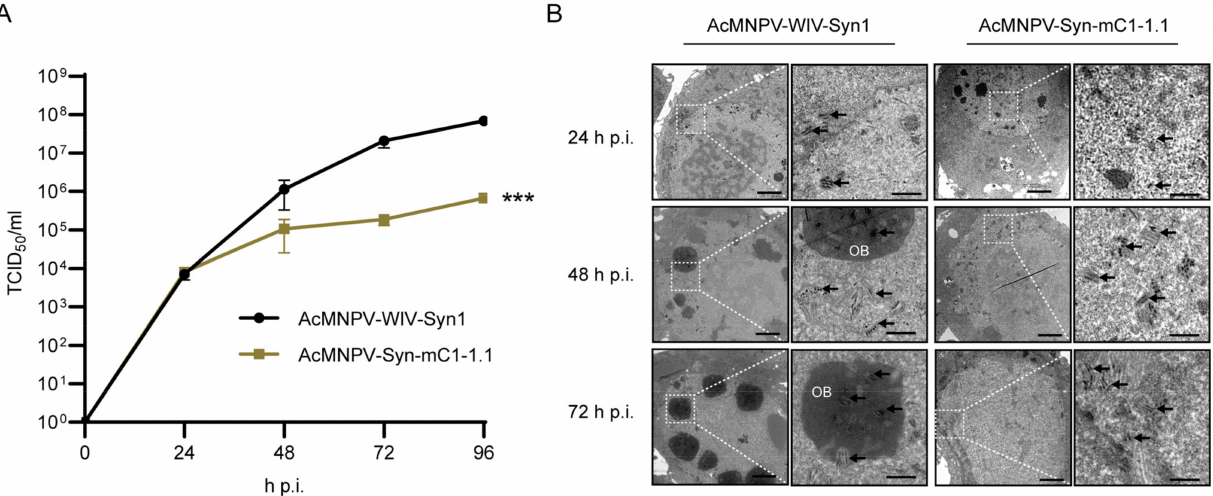
Figure 5. Characterization of AcMNPV-Syn-mC1-1.1. ( A ) One-step growth curves of AcMNPV-WIV- Syn1 and AcMNPV-Syn-mC1-1.1. Sf9 cells were infected with AcMNPV-WIV-Syn1 or AcMNPV- Syn-mC1-1.1 at an MOI of 1, the supernatants were collected at the indicated time points and viral titres were titrated by EPDA. The experiment was carried out in triplicate, and the titre was transformed logarithmically after averaging. Statistical significance was determined by 2way ANOVA. ***: p < 0.001. ( B ) Results of electron microscopy. Sf9 cells were infected with AcMNPV-WIV-Syn1 or AcMNPV-Syn-mC1-1.1 at an MOI of 5, and cells were collected at 24, 48, and 72 h p.i. for electron microscopy. The representative nucleocapsids are marked with arrows. OB: occlusion body. Scale bars are 2 µ m and 1 µ